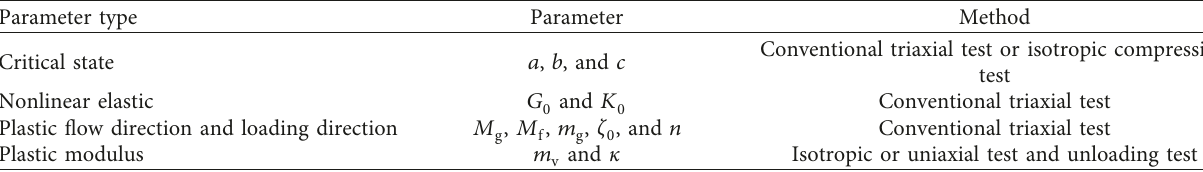
Table 1: Parameters and related tests of the enhanced model.